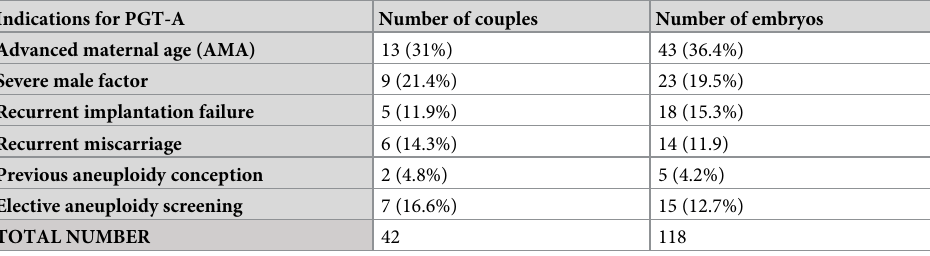
Table 1. Indications for Preimplantation Genetic Testing for Aneuploidy (PGT-A). Indications for